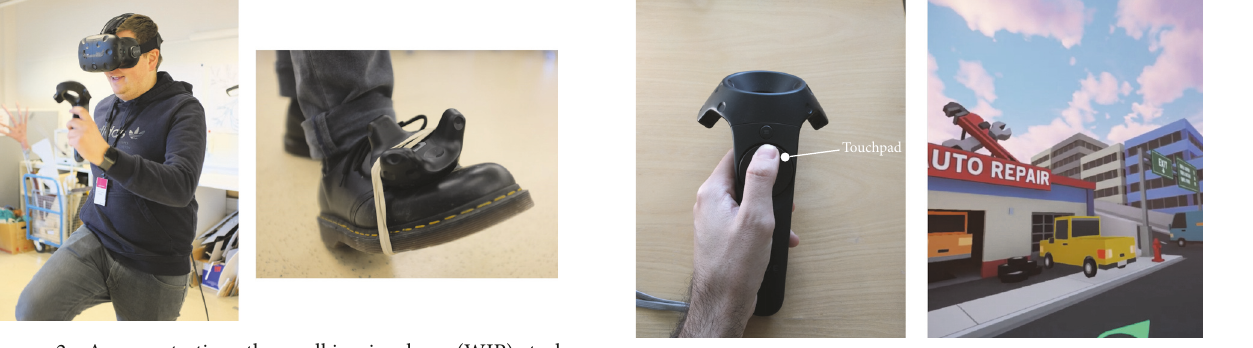
Figure 3: Interacting with the HTC Vive controller for the controller/joystick technique ( left ) and a view of the virtual environment ( right ). Video demonstration of virtual navigation: